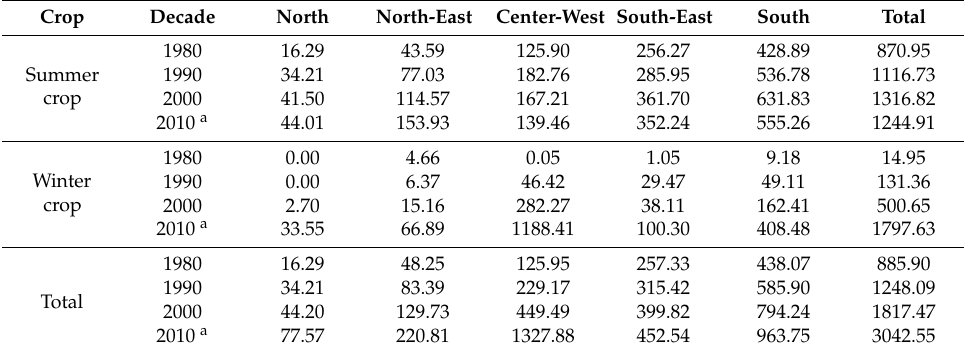
Figure 1. Brazilian corn production between 1980/81 and 2016/17. Source: Conab (Brazilian Food Supply Company). 1 Table 1. Brazilian corn production (annual average) by regions between 1980s and 2010s (million bushels). Crop Decade